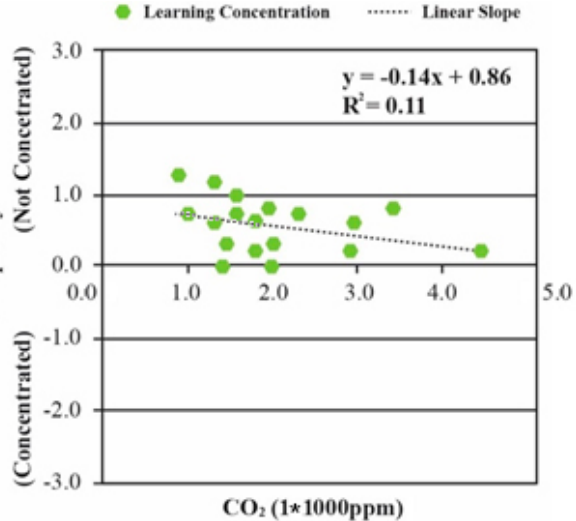
Figure 12. The frequency of concentration according to the CO 2 concentration.